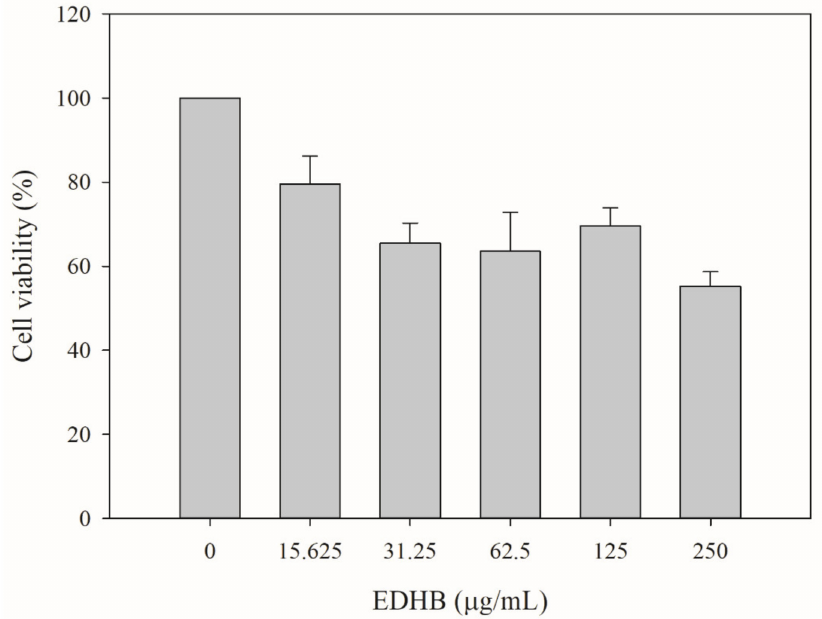
Figure 7. Cytotoxicity test of EDHB on human hepatic HepG2 cells. Data are expressed as mean ± SD ( n =